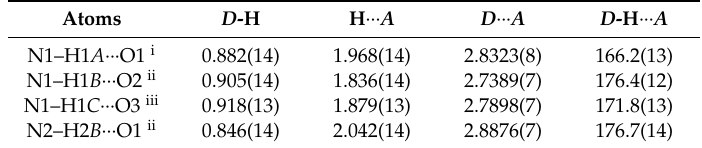
Table 4. Hydrogen bond geometry for γ -NADA at 100 K, distances in Å, angles in ◦